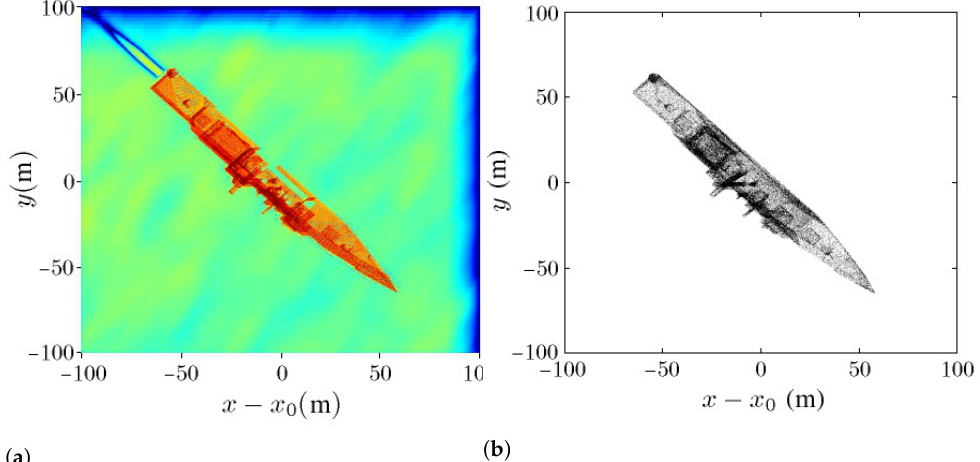
Figure 13. ( a ) Acquired image of Ticonderoga-class cruiser, in scale of (40, 90) dB and ( b ) scan image of 3D model.